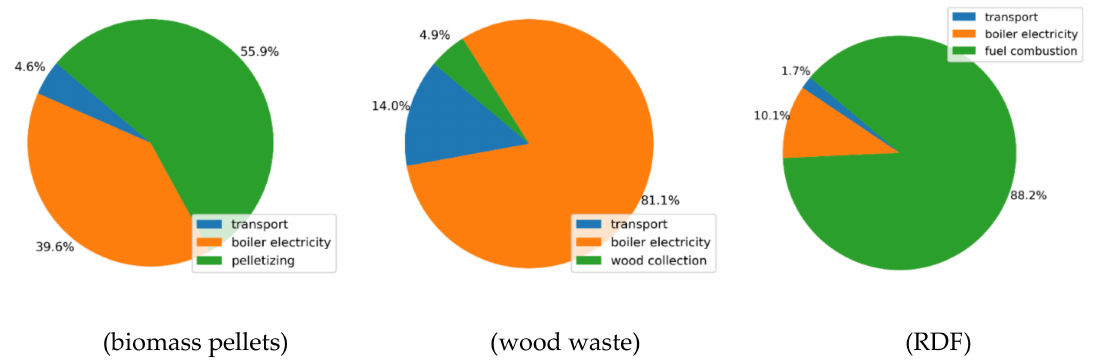
Figure 10. Proportion of three key contributors to the greenhouse gases for each feeding